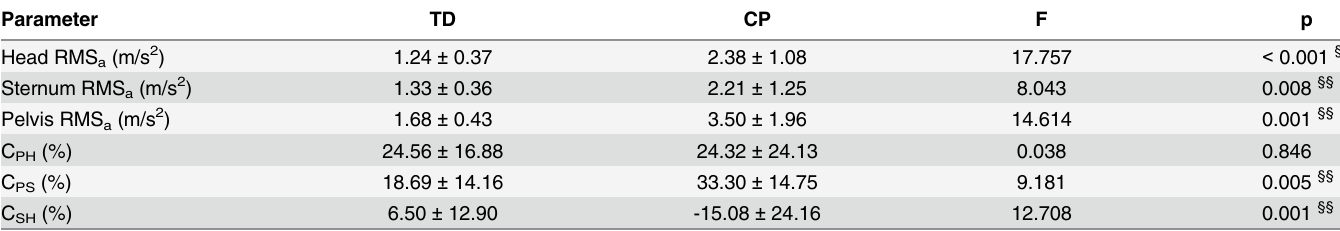
RMS of the magnitude of the accelerations (RMS a ) at pelvis, sternum and head levels and attenuation coef fi cients from pelvis to head (C PH ), from pelvis to sternum (C PS ) and from sternum to head (C SH ) computed in the TD and CP groups. Results are expressed as mean ± standard deviation. Results of the 2w-ANCOVA for the group comparison are also reported and signi fi cant differences (p < 0.01) are indicated with the symbol